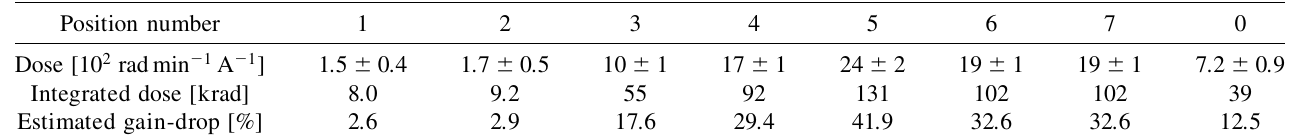
TABLE II. Results of a radiation-dose calculation for the period after starting the gain-drop (period II).